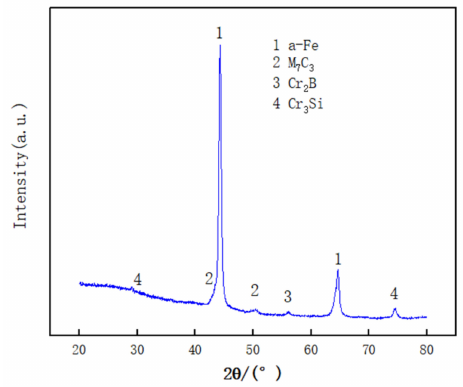
Figure 2. XRD pattern of the Fe-based alloy cladding